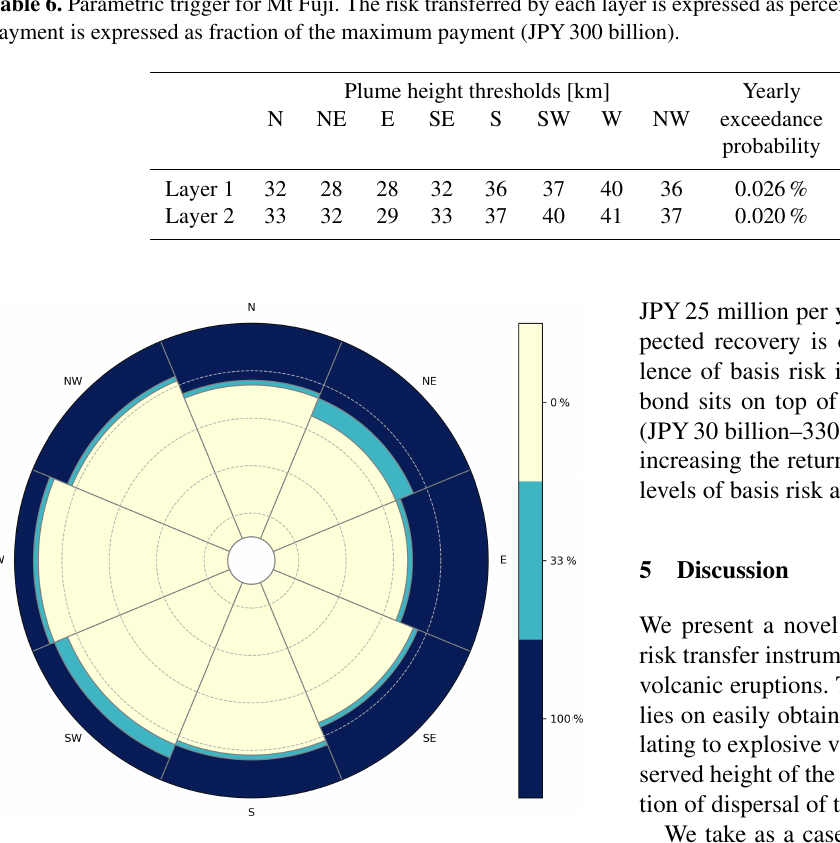
Figure 7. Parametric trigger for Mt Fuji. Each dashed line corre- sponds to a unit of